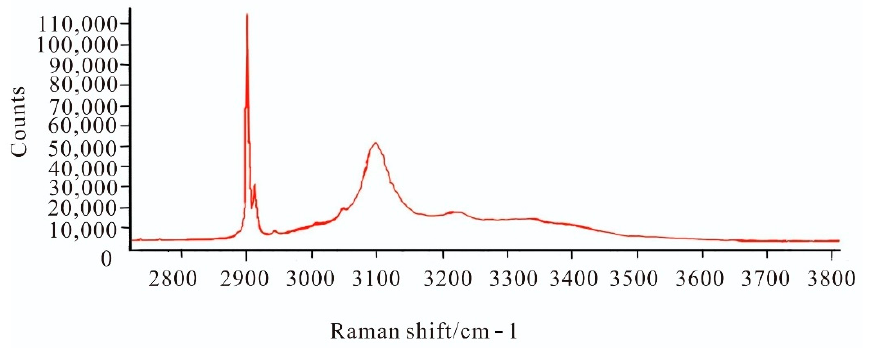
Figure 4. Laser Raman spectrum of gas